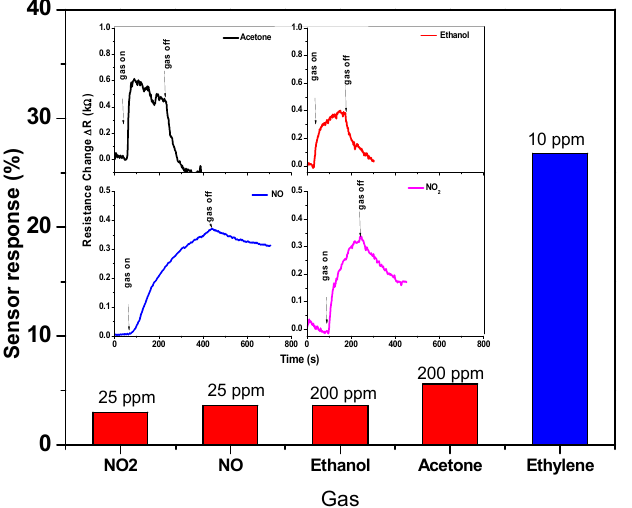
Figure 12. Sensor response toward various gases, such as NO 2 , NO, ethanol, acetone, and ethylene. The inset shows the sensor signal toward these gases.